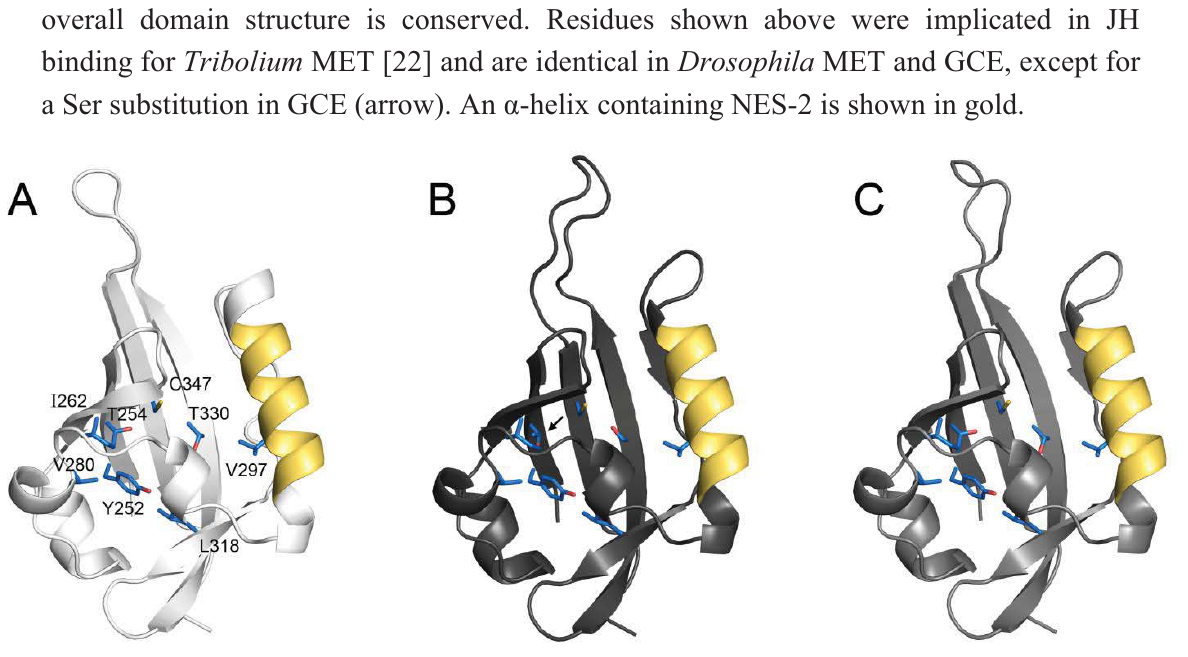
Figure 2. Conserved structure of the MET ligand binding domain. Homology models